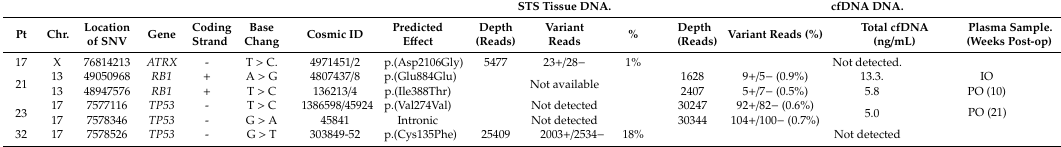
Table 2. SNVs identified in TP53 , RB1 and ATRX in STS or cfDNA from patients. STSTissueDNA.